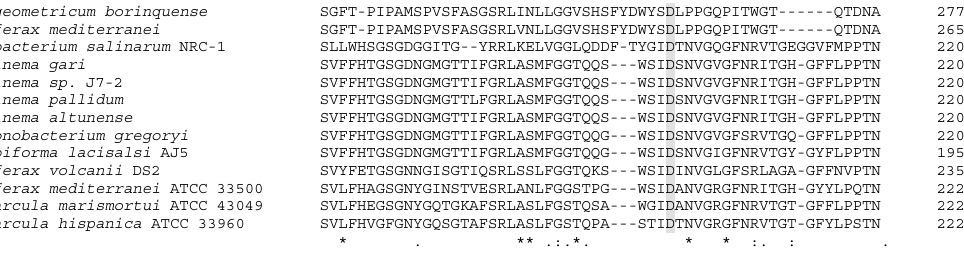
Figure 6. Clustal Omega alignment of halophilic respiratory nitrate reductases (NarG), TMAO reductases (TorA), and DMSO reductases (DmsA). In grey, aspartate which coordinates Mo atom in